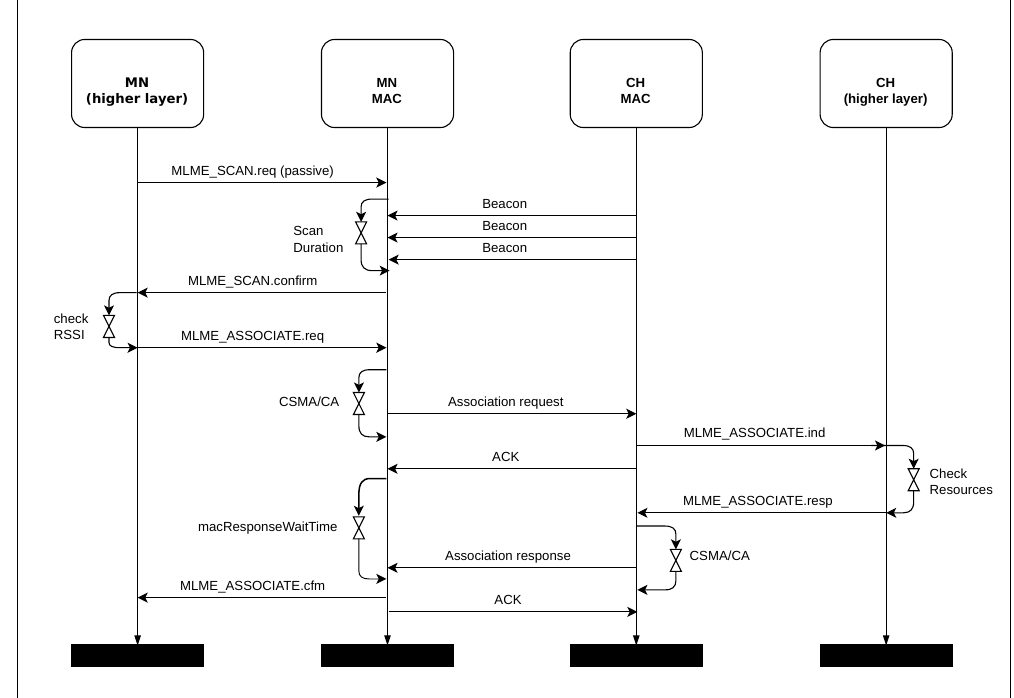
Figure 5. Message sequence chart for enhanced association